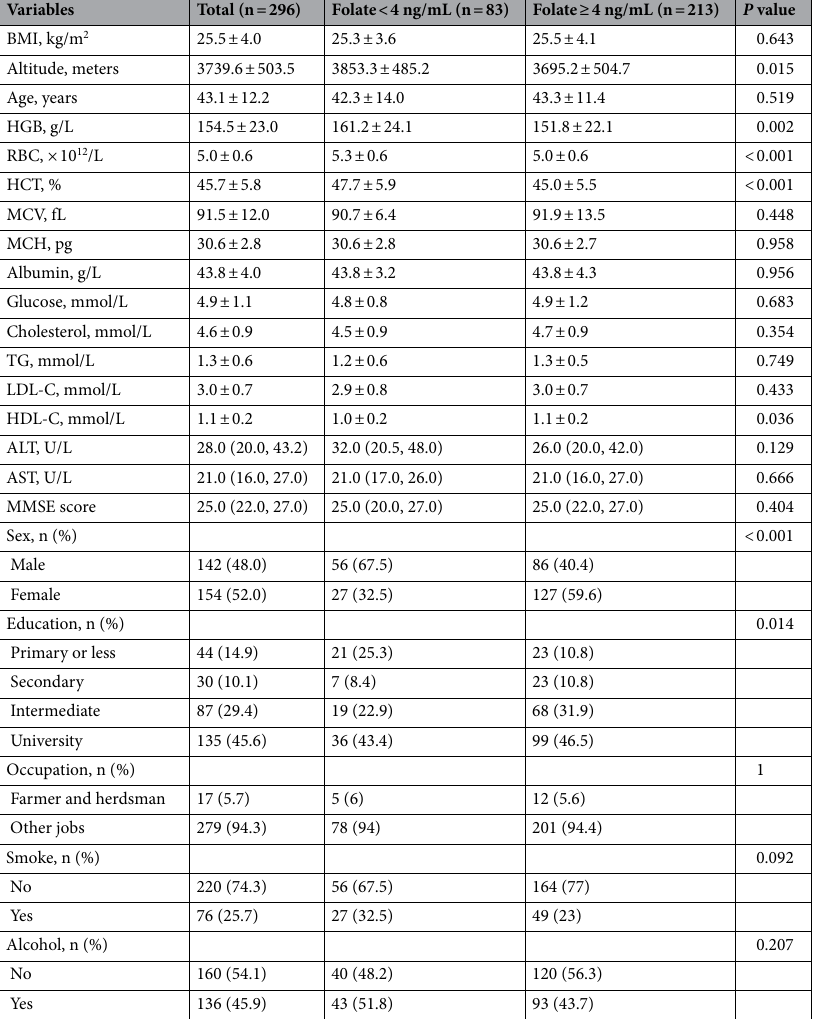
Table 1. Characteristics of the Tibetan healthy adults (n = 296) included in the study. Data are presented as the mean (SD) or median (IQR: Q1–Q3) for continuous variables and the percentage for categorical variables. BMI body mass index, HGB hemoglobin, RBC red blood cell, HCT hematocrit, MCV mean corpuscular volume, MCH mean corpuscular hemoglobin, TG triglycerides, LDL-C low-density lipoprotein cholesterol, HDL-C high-density lipoprotein cholesterol, AST aspartate aminotransferase, ALT alanine aminotransferase, MMSE Mini-Mental State Examination, SD standard deviation.